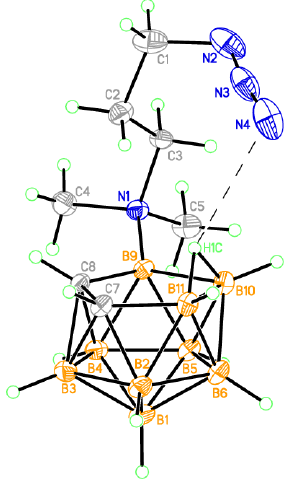
Figure 1. General view of 2 in crystal with the representation of non-hydrogen atoms by ellipsoids of atomic displacement ( p = 0.5). The intramolecular H1C…N4 contact is shown by the dashed line. Selected bond lengths: C7-C8 1.551(2) Å, B10-B11 1.862(2) Å, B9-N1 1.583(2) Å, H1C…N4 3.089 Å (non-normalized B-H bond lengths).